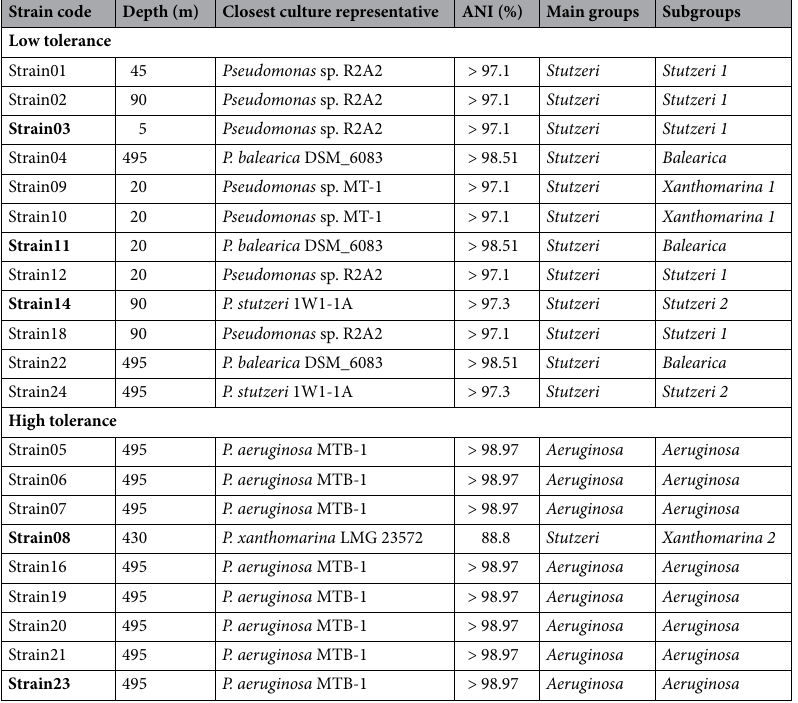
Table 1. Sampling depth, taxonomy assignment and phenotypic traits (i.e. high or low tolerance to acidity, antibiotics and heavy metals) of the 21 strains. All strains were closely related to six culture representatives and clustered into six subgroups (i.e. Stutzeri 1 and Stutzeri 2, Balearica, Aeruginosa, Xanthomarina 1 and 2). Strains in bold, representing each of the six subgroups, were used in phylogenetic tree construction presented in Fig.